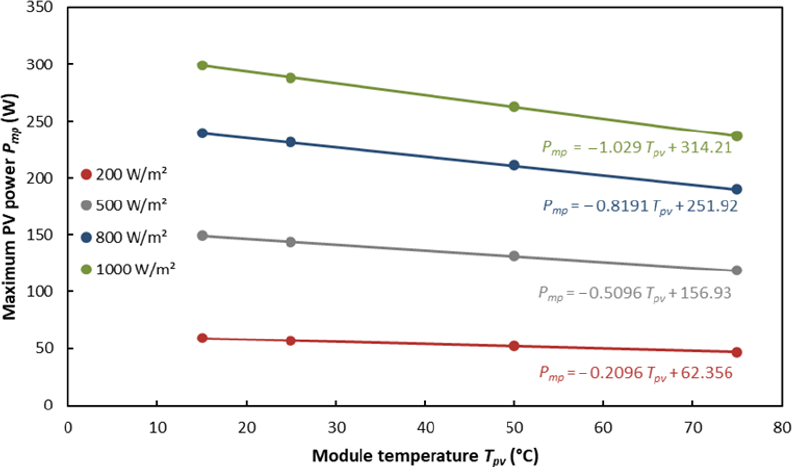
Figure 9. Maximum power dependence to module temperature at various irradiance levels.